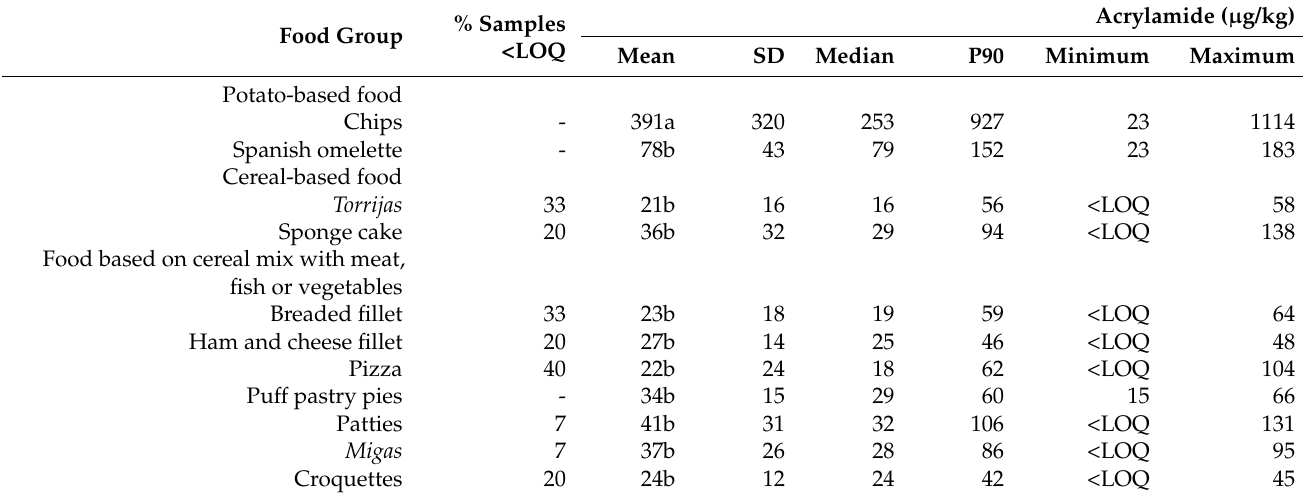
Table 1. Acrylamide content ( µ g/kg) in eleven groups of processed foods representing foods commonly consumed by the Spanish population.